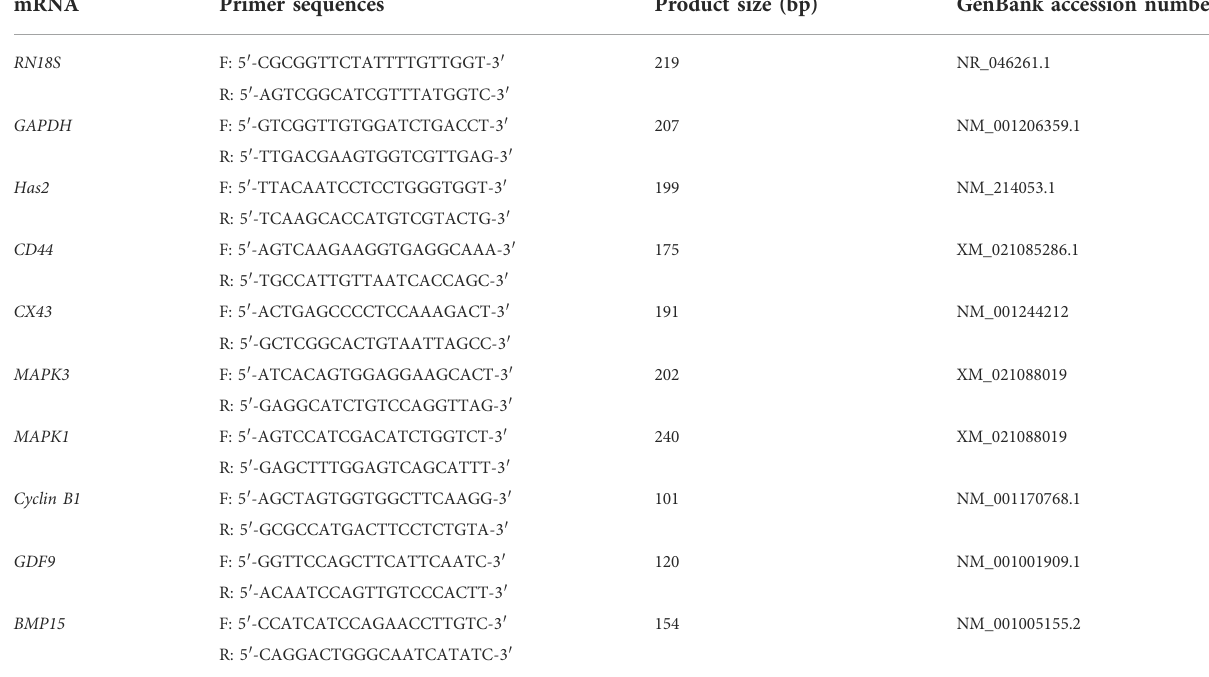
TABLE 1 Primer sequences for